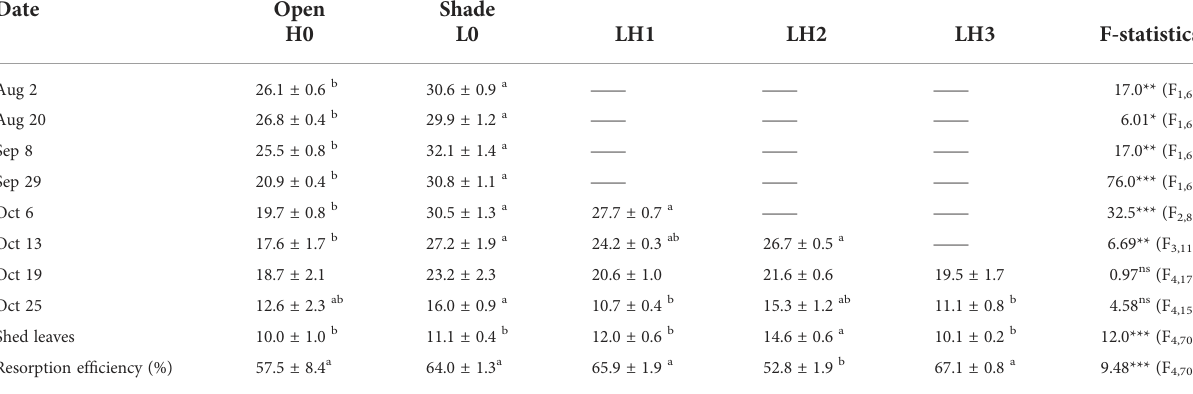
TABLE 2 Seasonal change in dry-mass based leaf N content (N mass , mg g -1 ) and resorption ef fi ciency (%) in leaves of fullmoon maple seedlings grown under different light